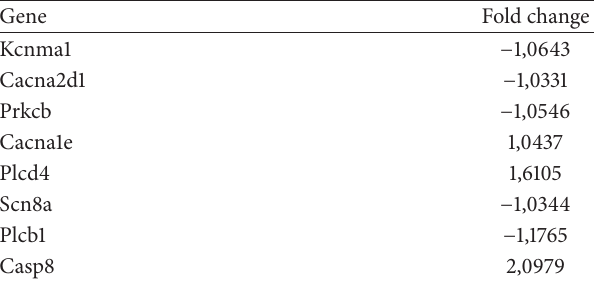
Figure 4: Time-frequency analysis of theta activity in control and 5XFAD mice. (a) Color-coded time-frequency plot of extracted theta segments from EEG data. These segments were clued together (13 minutes in total) for a better demonstration of the oscillatory activity. The 𝑦 -axis represents the frequency range of 4–12 Hz. (b) Mean theta frequency (Hz) calculated for the hippocampal theta- alpha band (4–12 Hz). Note that (a) and (b) display specific episodes of consistent, high amplitude, low frequency EEG activity that was proven to be related to behavioral aspects such as grooming, scratching, or eating based on video analysis. A specific algorithm was defined to automatically detect and eliminate these episodes from further evaluation (black bars, (b)). Table 2: Fold changes in gene expression of 5XFAD transgenic mice compared to WT